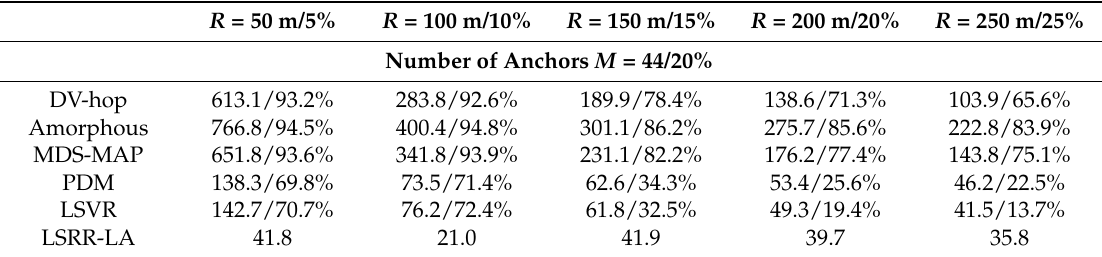
Table 3. Comparison of the average localization error (ALE) under different radio ranges in the regular distribution network. R = 50